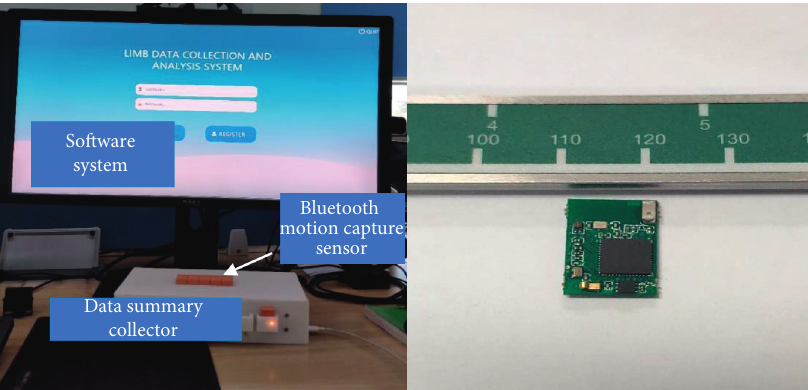
Figure 5: Overall system and sensor circuit board diagram. Table 1: Net size comparison of sensors with the same function.